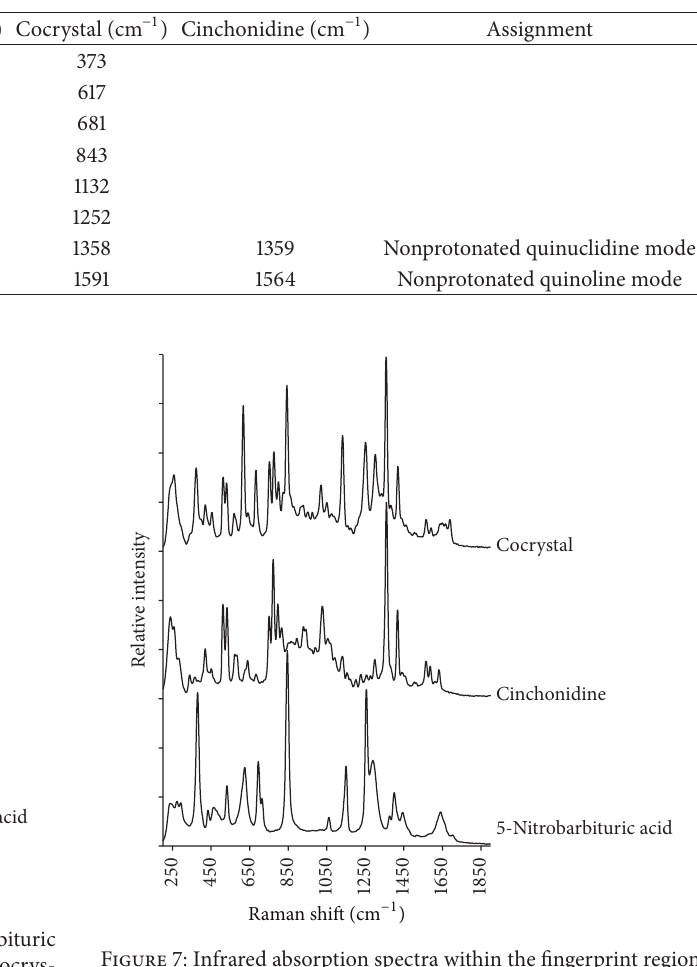
Table 4: Assignments of the major bands in the fingerprint region of the Raman spectra of 5-nitrobarbituric acid, cinchonidine, and their 1: 1 cocrystal product.